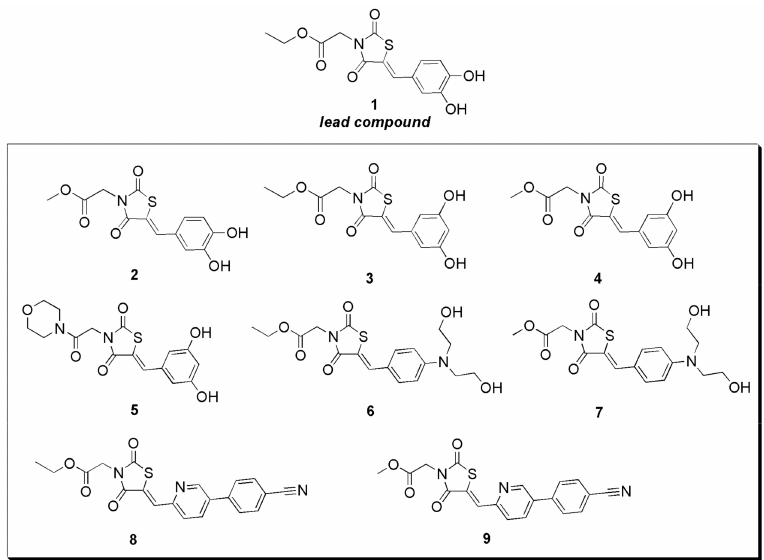
Figure 2. Chemical structures of new 2,4-thiazolidinedione derivatives 2 – 9 and lead compound 1